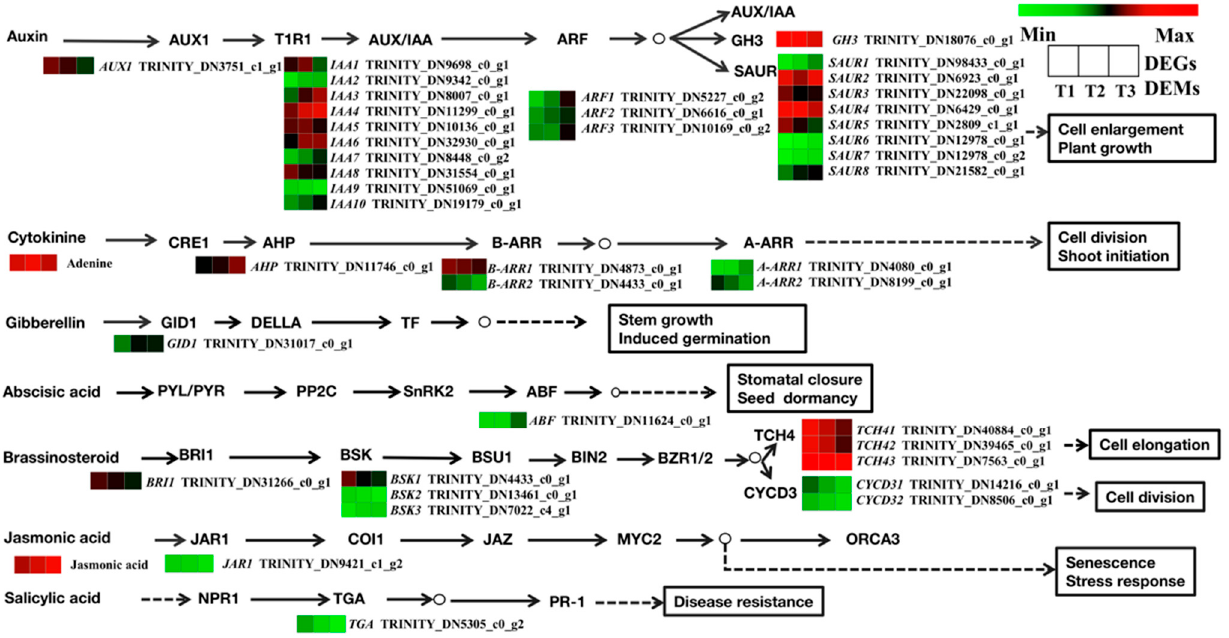
Figure 11. Regulatory network of plant hormone signal transduction in three different root samples. The color scale from green to red for the heatmap represents downregulated and upregulated expression. AUX1, auxin influx carrier; AUX/IAA, auxin-responsive protein/indole-3-acetic acid; ARF, auxin response factor; GH3, auxin-responsive GH3 gene family; SAUR, small auxin-up RNA family protein; A-ARR, two-component response regulator A-ARR family; B-ARR, two-component response regulator B-ARR family; GID1, gibberellin receptor GID1; ABF, ABA-responsive element binding factor; BRI1, protein brassinosteroid insensitive 1; TCH4, xyloglucan:xyloglucosyl transferase TCH4; CYCD3, cyclin D3; JAR1, jasmonic acid-amino synthetase; TGA, transcription factor TGA.